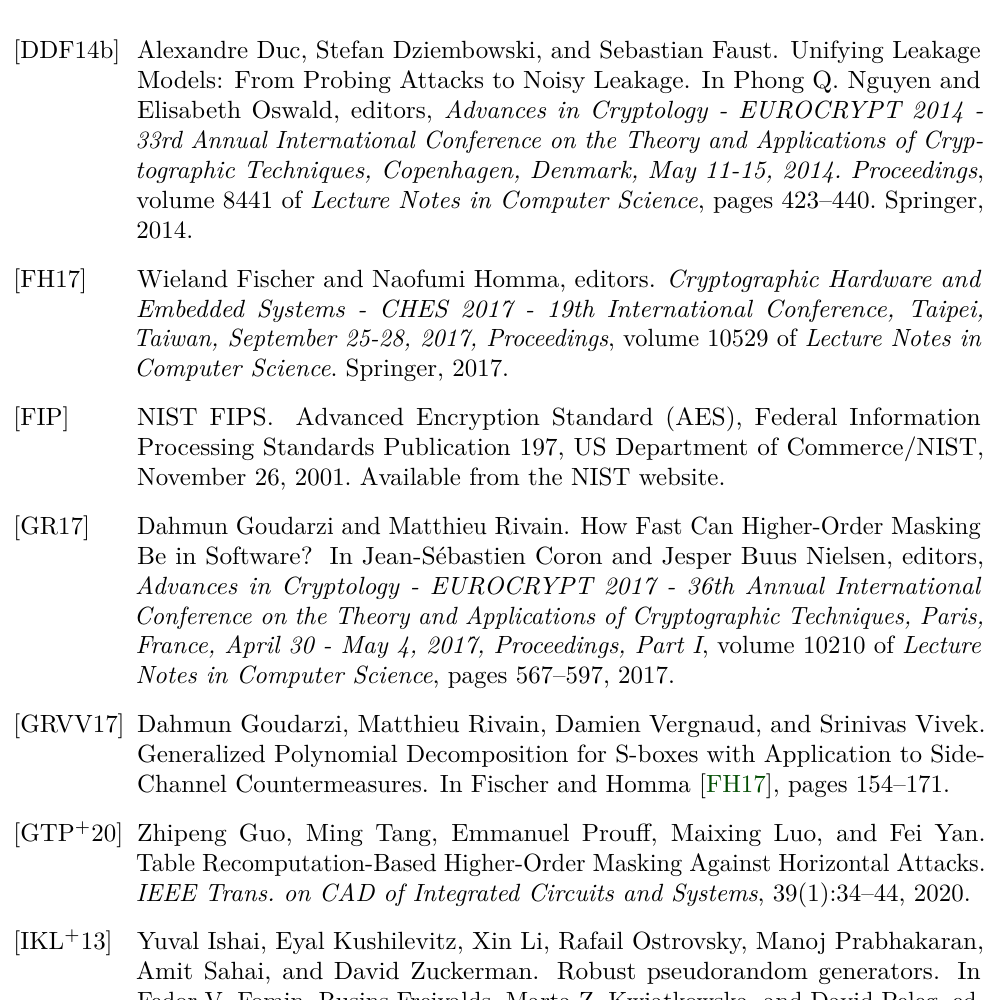
Table Recomputation-Based Higher-Order Masking Against Horizontal